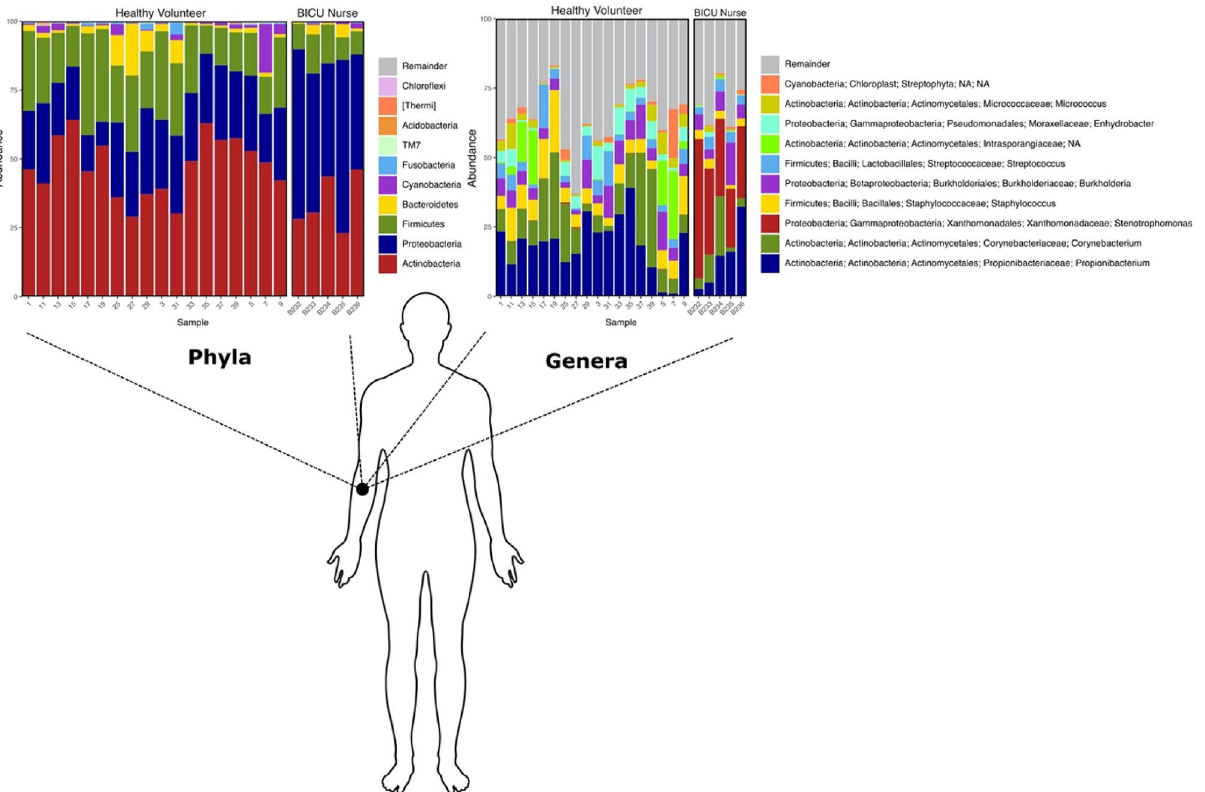
Figure 3. Healthy volunteer and BICU nurse taxonomic summary. Summary of the relative abundance of the top 10 phyla and genera level taxa on the healthy volunteer and BICU nurse cohorts. Phyla and genera are listed descending from least to most abundant. This figure was generated using the software Inkscape and graphical taxonomic output from